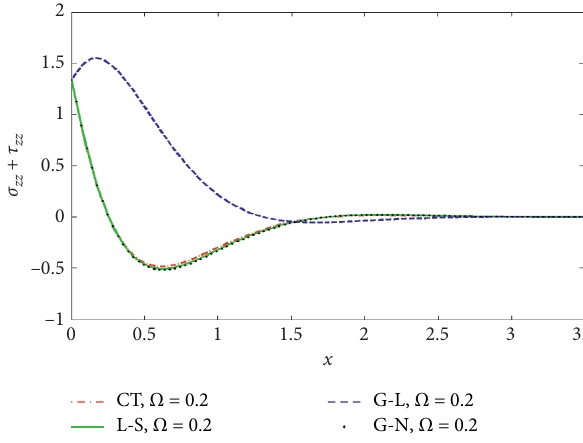
x under four thermoelastic